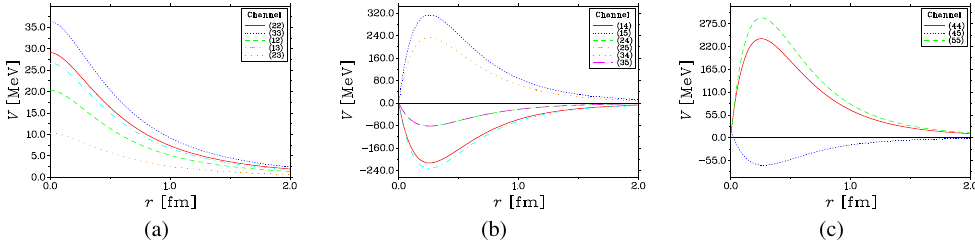
Fig. 5. Diagrams (a), (b), and (c) show diagonal and transition potentials of S -wave case, S - D transition case, and D -wave case with the cuto ff parameter Λ π = 1 . 0 GeV, respectively. ( ij ) denotes the potential V ij ( Λ π , r